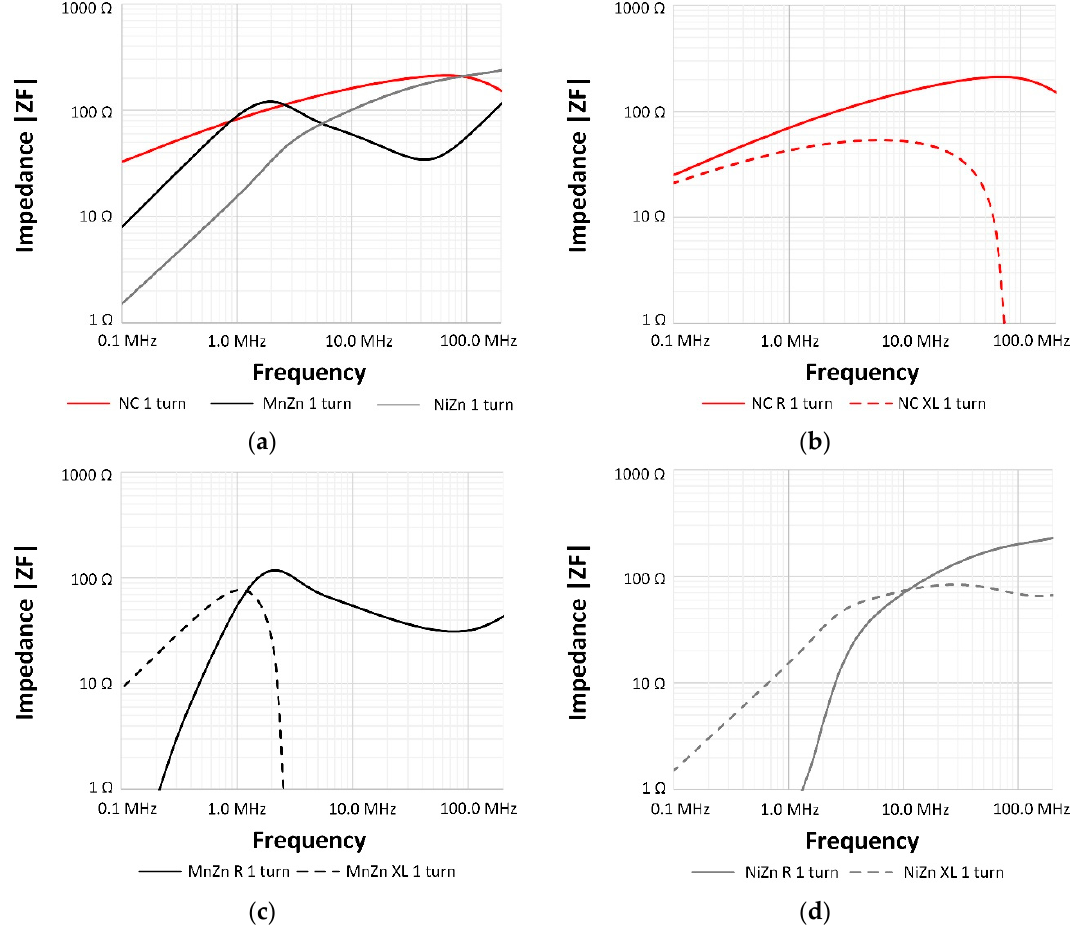
Figure 7. Impedance measurements of the NC, MnZn and NiZn sleeve ferrites winding around them 1 turn: ( a ) Magnitude impedance of three cable ferrites; ( b ) NC R and X L impedance components; ( c ) MnZn R and X L impedance components; and, ( d ) NiZn R and X L impedance components.